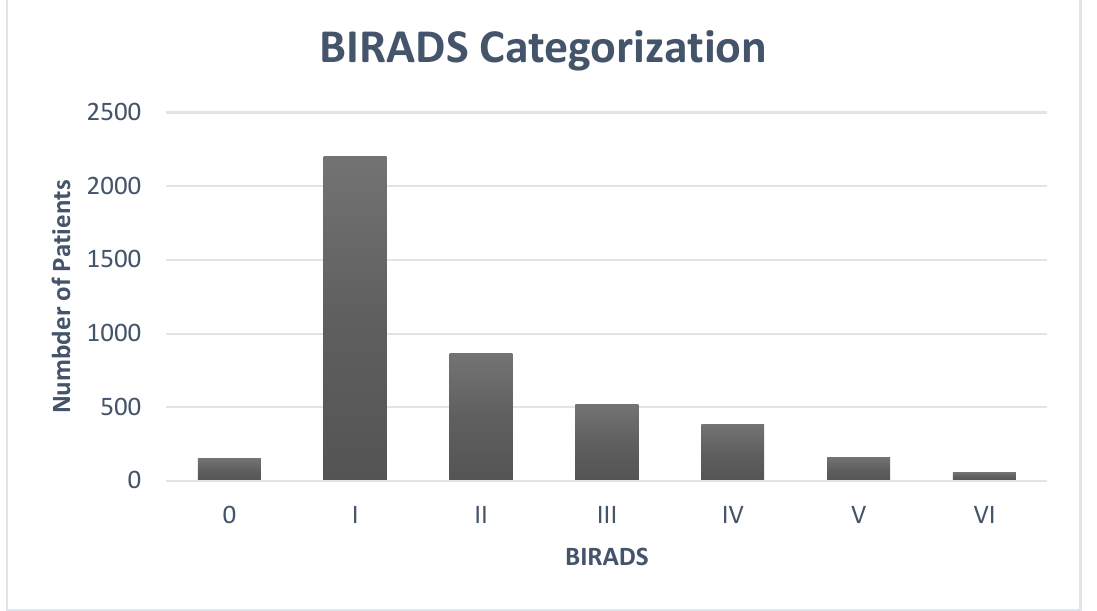
Figure 5. The BIRADS categorization of women with mammogram screening.